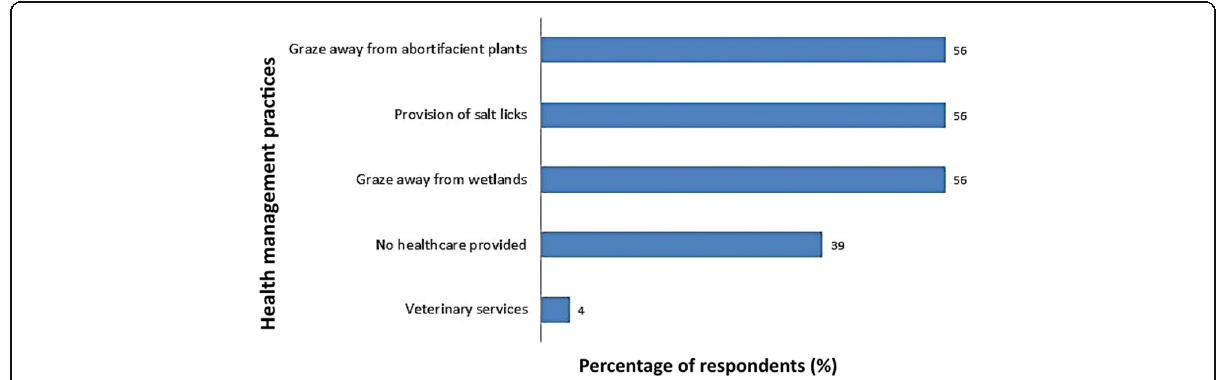
Figure 5 Health management practices among camel herders in Northeastern